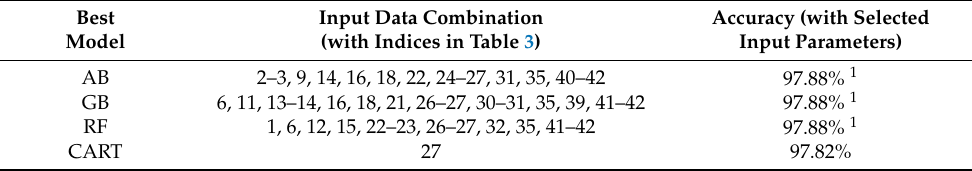
Table 6. Accuracy of each machine learning technique after reduction of input data.